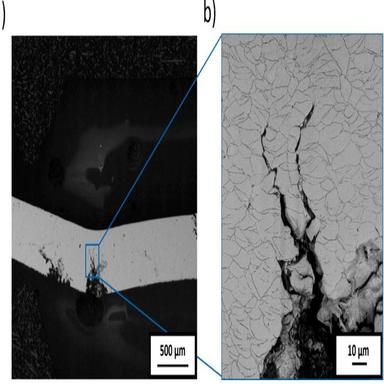
Crack propagation in as-sprayed copper (ASC-1).